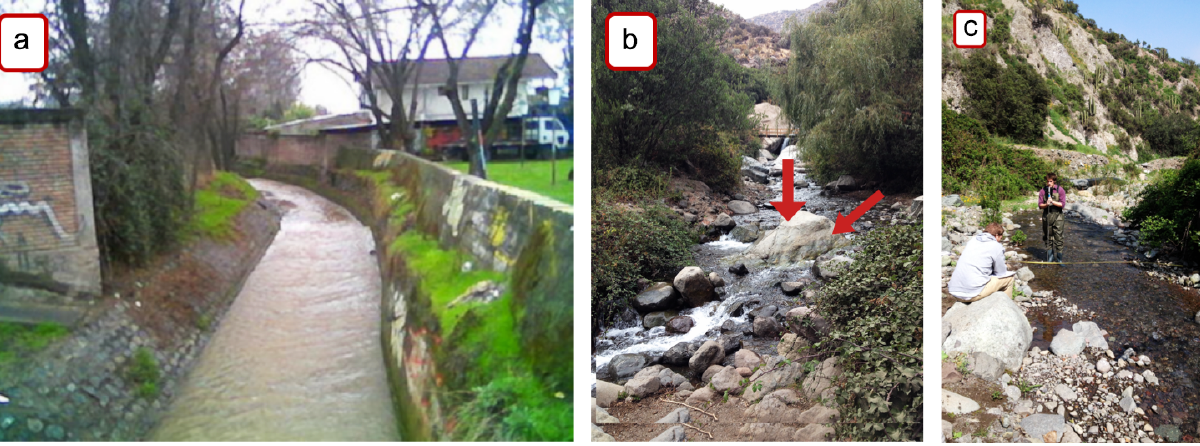
Figure 2. Three photos along the Quebrada de Ramón stream from downstream to upstream: (a) the channelized section, (b) the floodplain, and (c) the confluence of the Quebrada de Ramón and the Quillayes